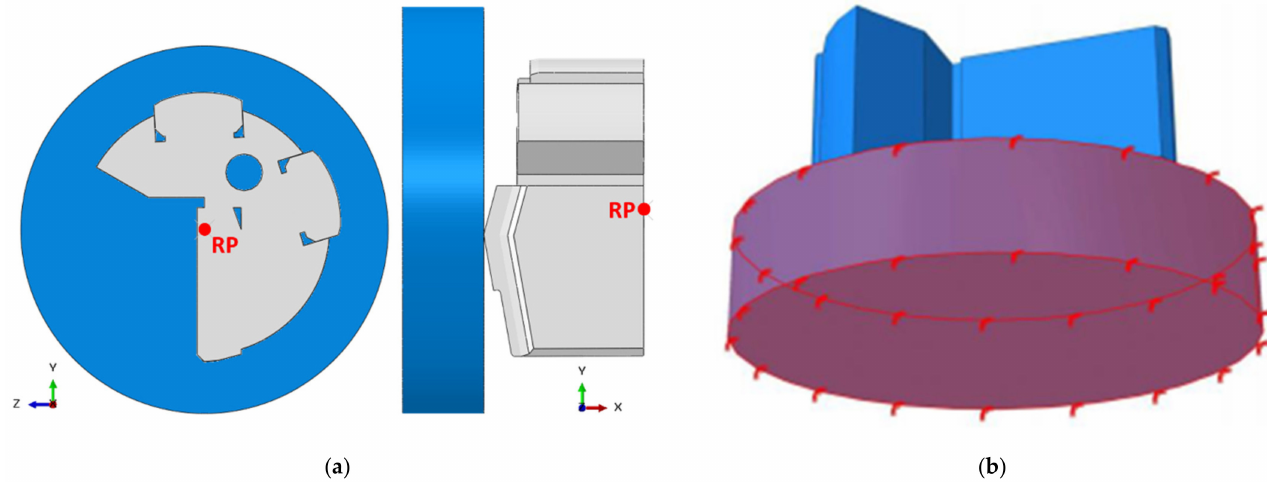
Figure 4. Location of the reference point ( a ) and symmetry/antisymmety/encastre boundary condition ( b